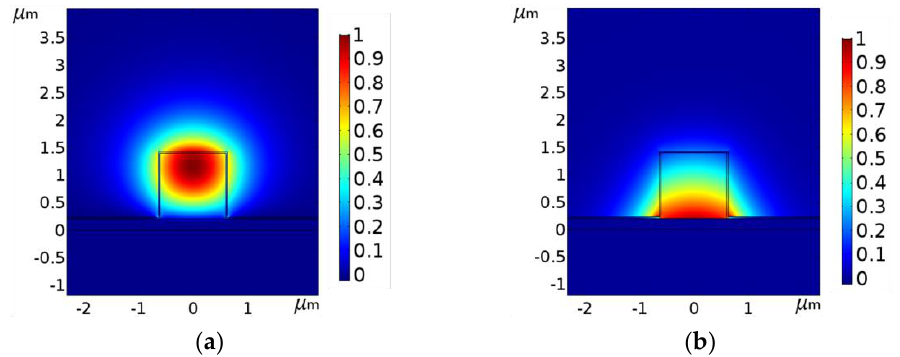
Figure 1. ( a ) 3D schematic and ( b ) cross sectional view of the proposed sensor.